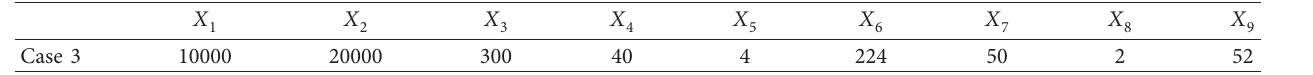
Table 5: Types and quantity of emergency resources needed for case3.